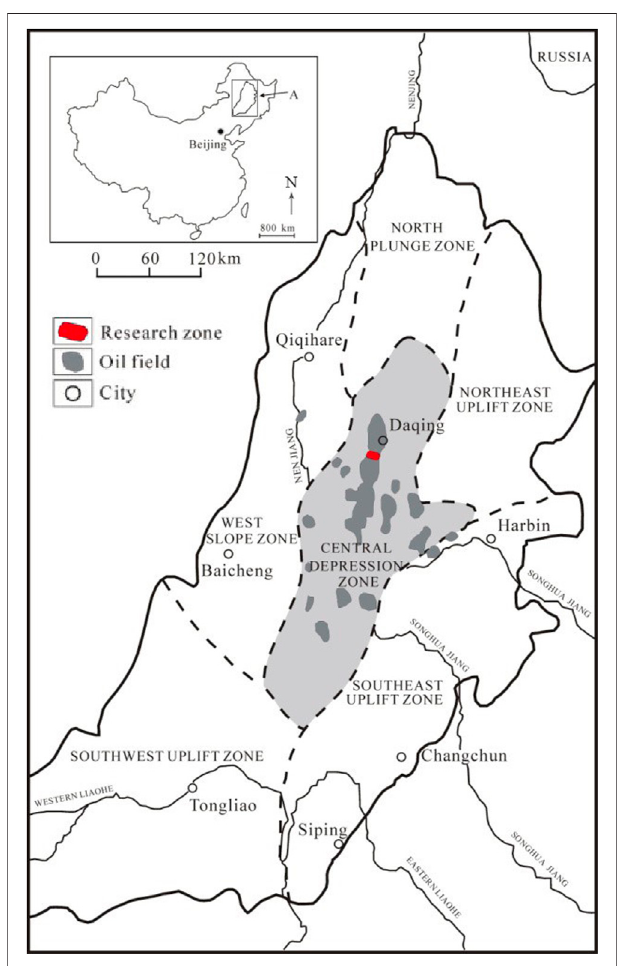
FIGURE1| LocationoftheNanerZoneintheSaertuOil fi eld(A:Location of the Songliao Basin).